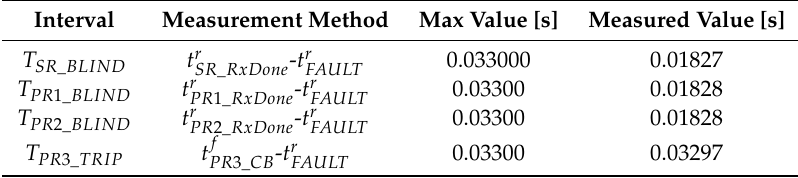
Table 19. Estimated time intervals during the fault 50.S3 between PR3 and